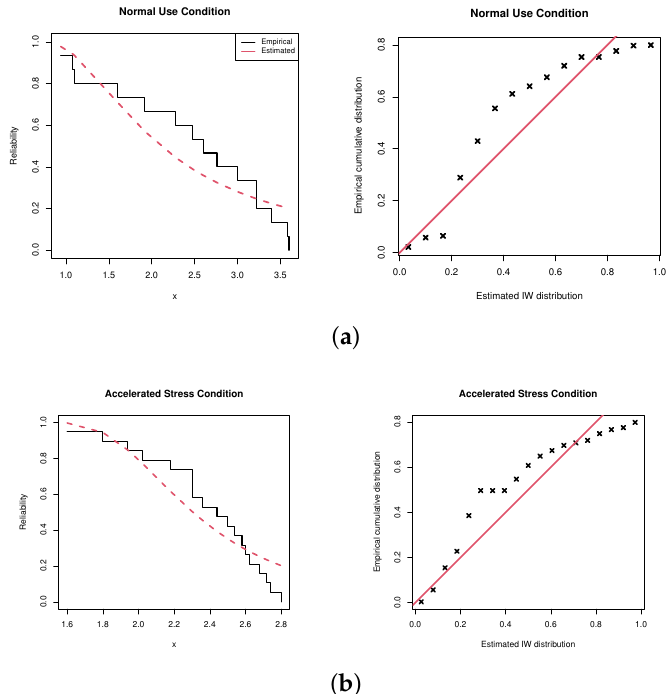
Table 4. Since there is no available prior information, the hyper-parameters of α , β and λ are set to be 0.001; although the prior densities for all parameters are considered proper, this setting implies that the prior densities are almost noninformative. Employing the MCMC procedures presented in Section 5, we reproduced 50,000 Markov chain variations. The initial guesses of α , β , and λ for running the MCMC sampler were assumed to be their frequentist estimates. To discard the impact of initial guesses, the first 10,000 variants of each generated chain were removed. In Table 5, the acquired point and interval estimates of α , β and λ obtained by the frequentist approaches (including ML and MPS methods) and Bayes procedures (including LF-based and PSF-based methods) are computed and declared. It can be seen from Table 5 that the point estimates for all unknown parameters act similarly and seem close to each other, as anticipated. An identical performance is also seen in the case of interval estimates. It also shows, in terms of the smallest SEs and shortest interval length, that the Bayesian point (or interval) estimates developed from PSF-based methods perform well compared to those obtained from LF-based methods, and both are more satisfactory than the frequentist estimates. The consequences detailed in Table 5 support the same conclusions as in Section 6.